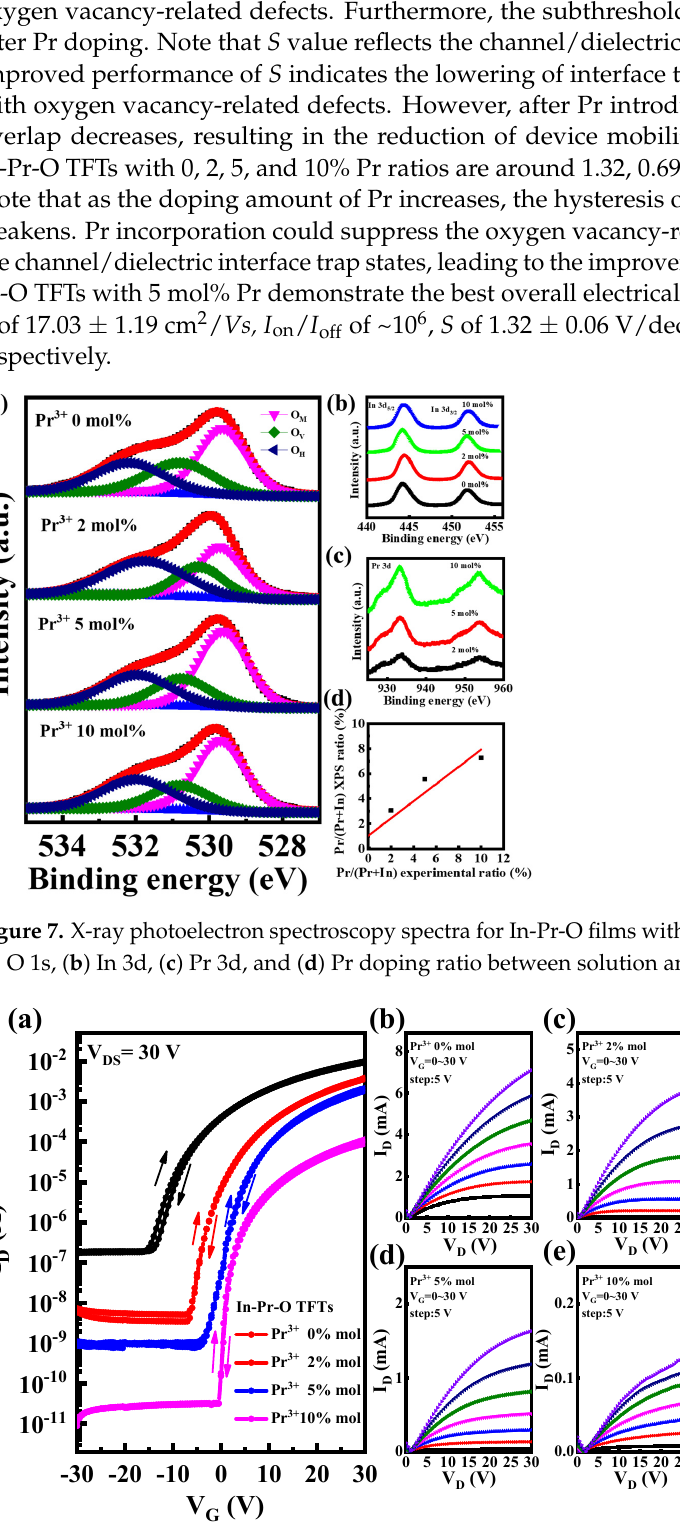
Figure 8. ( a ) Transfer and ( b – e ) output curves for In-Pr-O TFTs with 0, 2, 5, and 10 mol% Pr con- centrations.